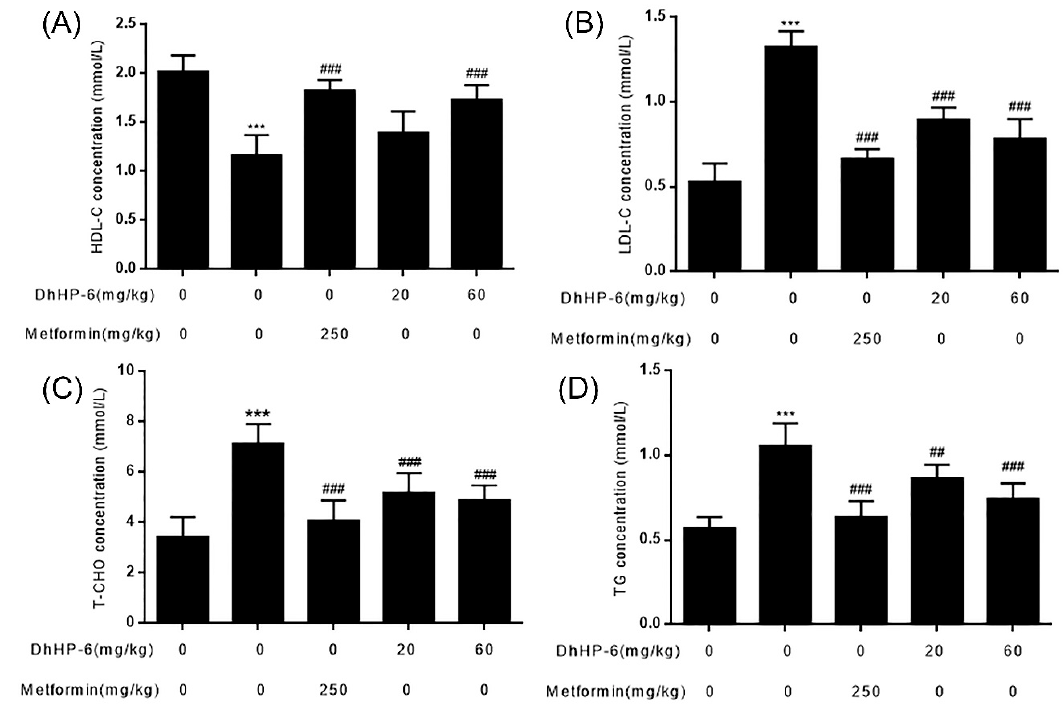
Figure 8. The serum lipid profile was tested on the day of sample collection. ( A – D ) HDL-C, LDL-C, T-CHO, and TG in serum were measured. All results presented are means ± SD, n = 8. *** p < 0.001 vs. control group. ## p < 0.01, ### p < 0.001 vs. model group.